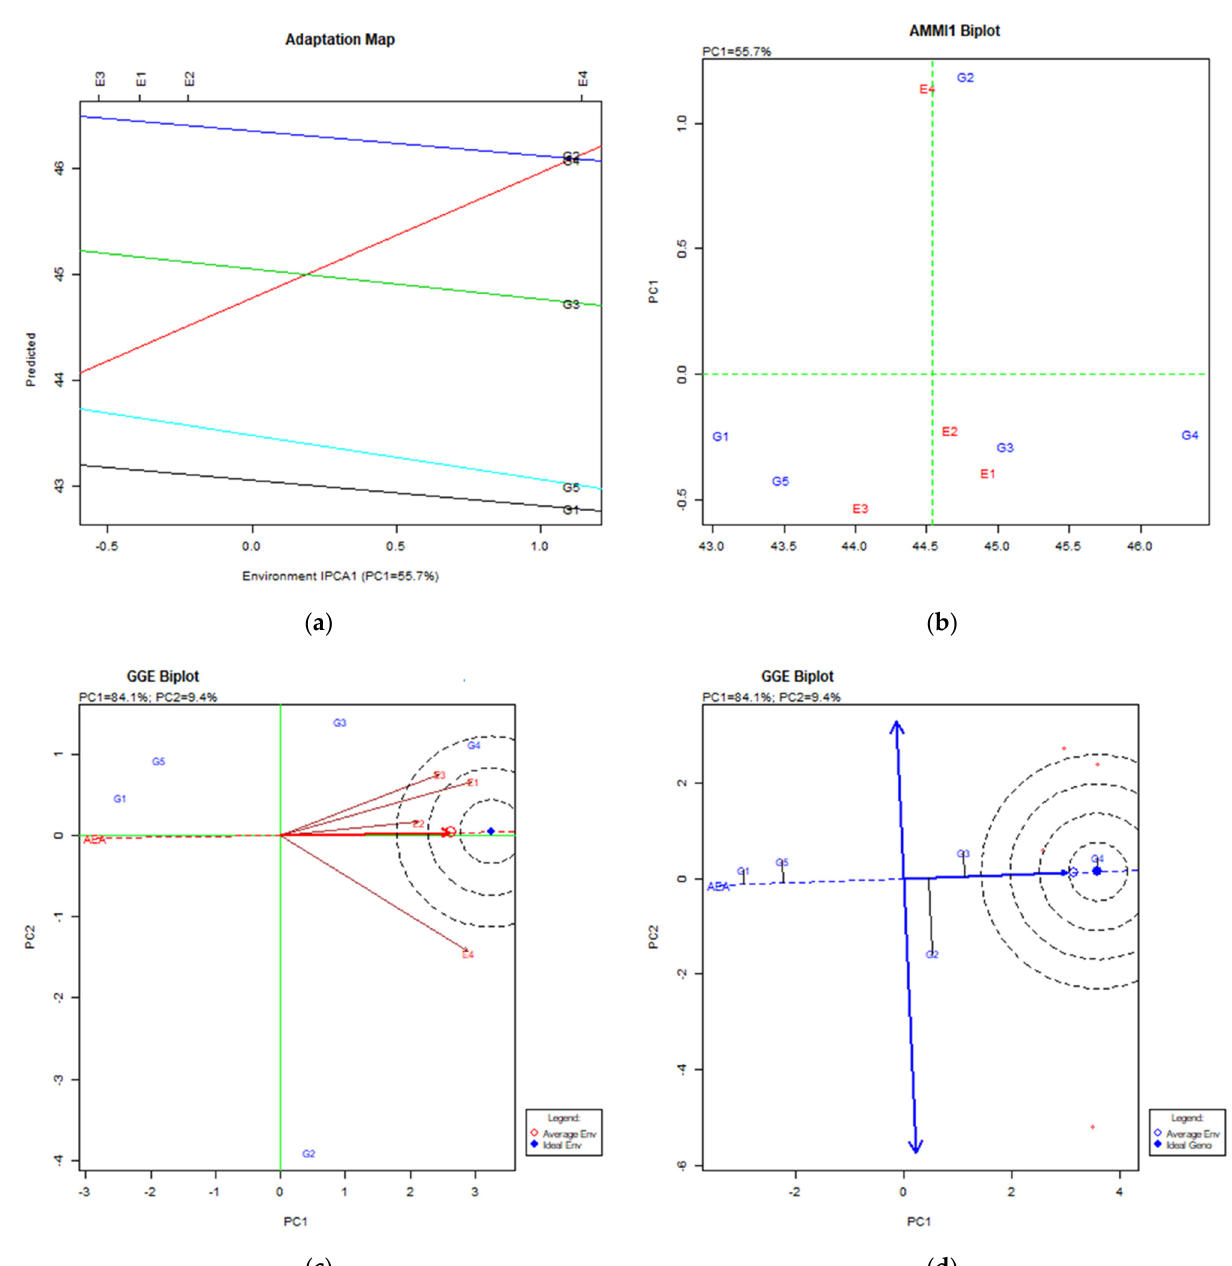
Figure 8. Stability analysis for pod length (cm) based on: ( a ) the adaptation map where the X-axis (PC1) visualizes the stability of cultivars over environments and the Y-axis—the performance of cultivars for the trait; ( b ) the AMMI1 biplot where the Y-axis is the one visualizing the trait performance and the X-axis (PC1) visualizes the stability of cultivars over environments; ( c ) the GGE biplot for environments depicting the stability of the environments over years via the placement as near as possible to the ideal and average environment; ( d ) the GGE biplot for cultivars depicting the stability of the cultivars over environments where the productive cultivars are those to the right on the AEA vector and the stable ones are those which are as close to the AEA axis as possible.